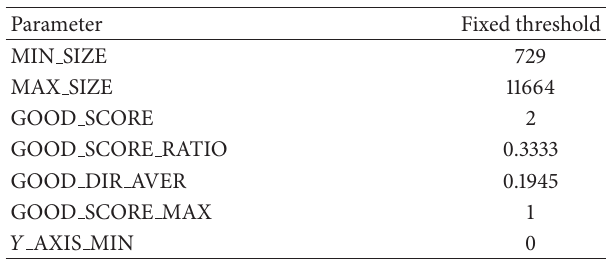
Table 6: The fixed threshold we